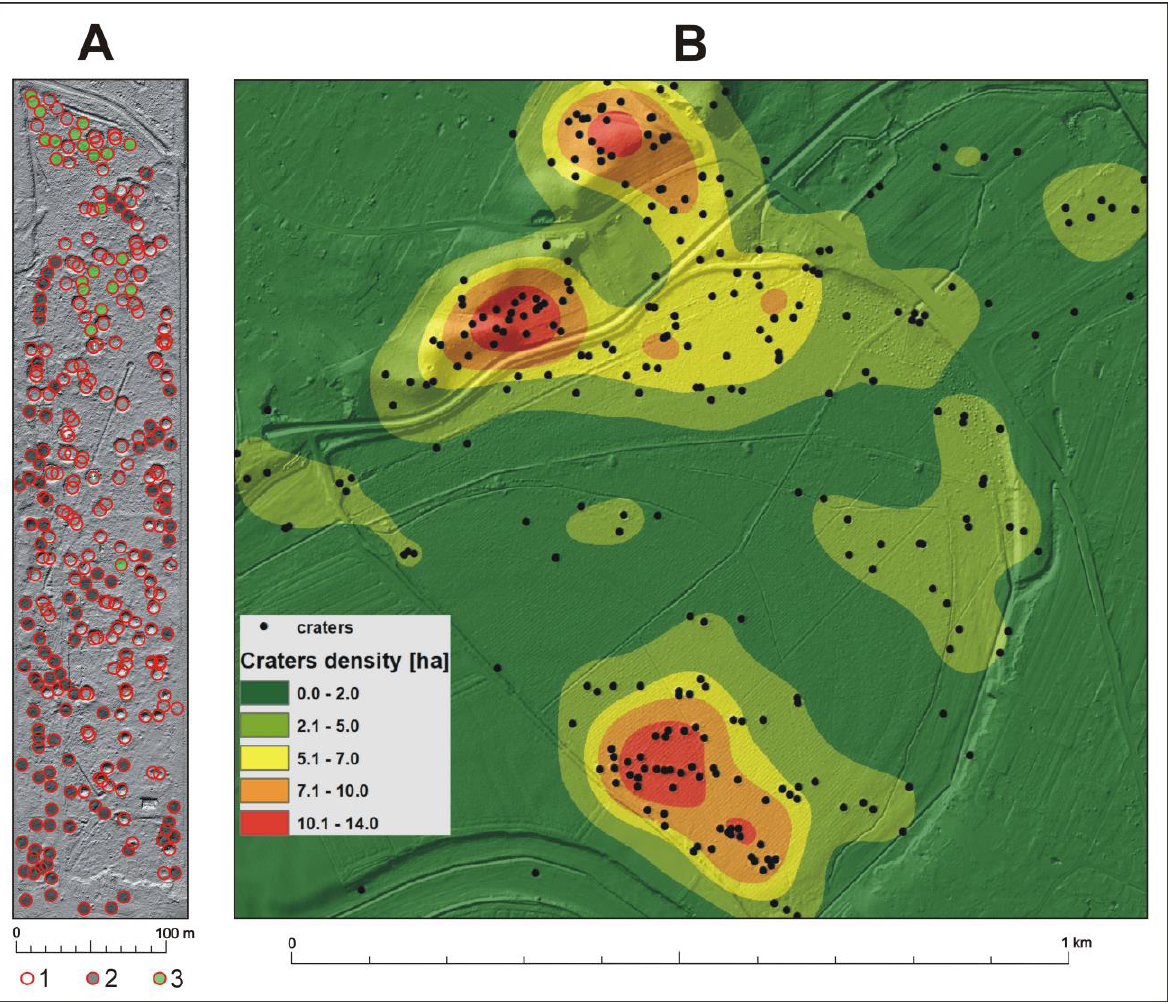
Fig. 5. Two proving grounds near Kędzierzyn-Koźle (figure by the authors) A. Location and preservation status of craters. Craters: 1 – well preserved, 2 – backfilled, 3 – strongly altered by natural geomorphological processes. B. Crater